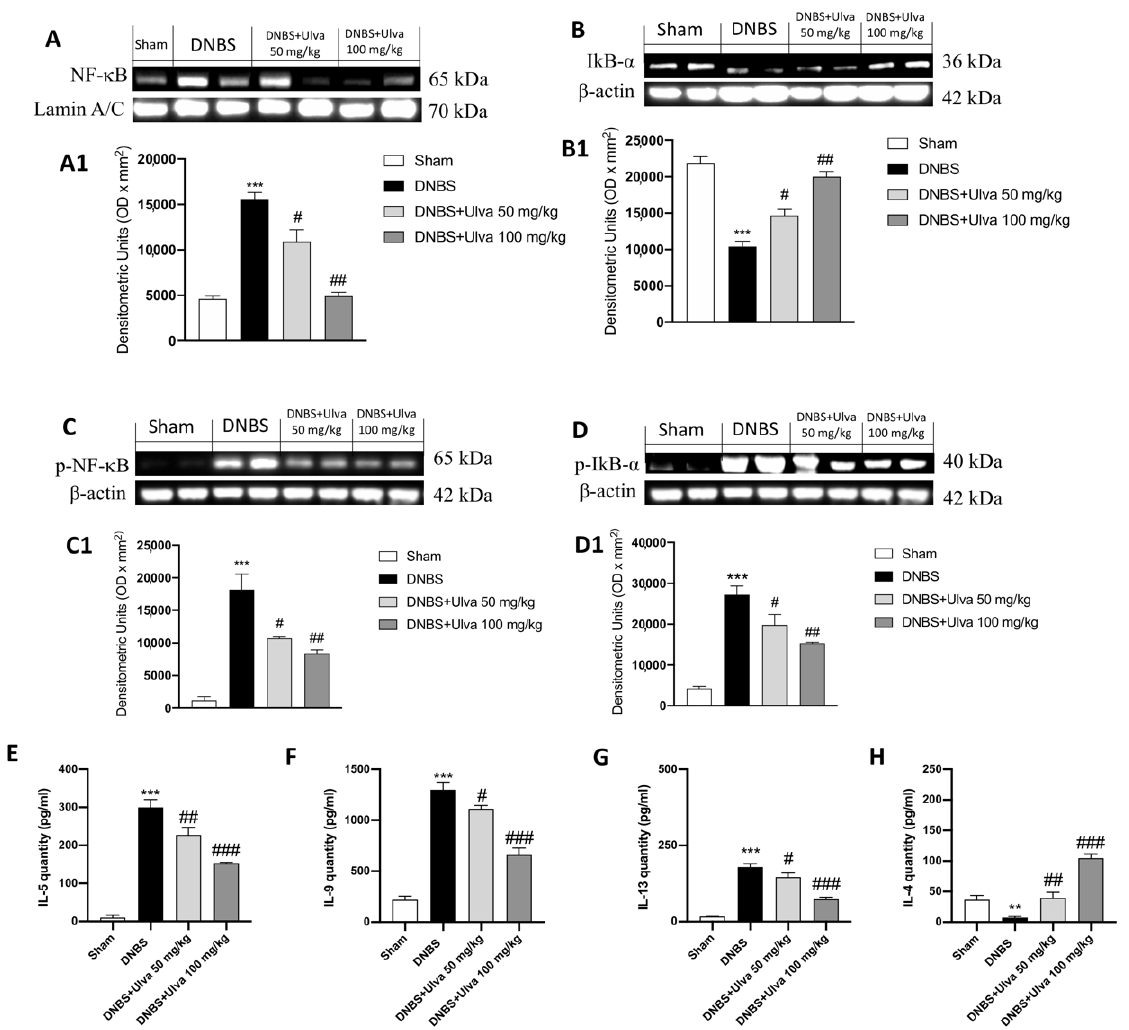
Figure 3. Effect of Ulva pertusa on NF- κB pathway and interleukin’s production. IκB - α basal levels were identified in sham mice, differently an increase in the degradation of IκB - α was found in the DNBS-vehicle group ( A ), densitometric analysis ( A1 ). Against, NF- κB expression was significantly increased in the DNBS group compared to the sham group ( B ), densitometric analysis ( B1 ). How- ever, Ulva pertusa 50 mg/kg and 100 mg/kg restored IκB - α expression ( A ), densitometric analysis A1 and decreased NF- κB one ( B ), densitometric analysis B1 . These results were also confirmed by the evaluation of phosphorylated proteins ( C ), densitometric analysis ( C1 ) and ( D ), densitometric anal- ysis ( D1 ). In serum, a substantial increase in the levels of interleukins -5, -9, and -13 was detected in the animals of the DNBS group compared to the Sham group ( E – G ). Treatment with Ulva pertusa reduced this expression in a dose-dependent manner ( E – G ). In contrast, IL-4 was decreased in DNBS mice compared to the control group ( H ); treatment with Ulva pertusa led to dose-dependent overexpression of IL-4 ( H ). Data are representative of at least three independent experiments. Val- ues are means ± SD. One-way ANOVA test followed by Bonferroni. ** p < 0.01 vs. Sham; *** p < 0.001 vs. Sham; # p < 0.05 vs. DNBS; ## p < 0.01 vs. DNBS; ### p < 0.001 vs. DNBS. 3.4. Ulva pertusa Treatments Reduced Pro-Inflammatory Mediators Release of iNOS, COX-2 and Attenuated Nitrosative Stress Macroscopic damage to the colonic environment is well reported to be associated with a high expression of COX-2 and iNOS expression according to the activation of the nitrosative stress [39]. We observed that there was a strong increase of both inflammatory mediators’ expression in colon tissue of DNBS -injected mice compared to the control